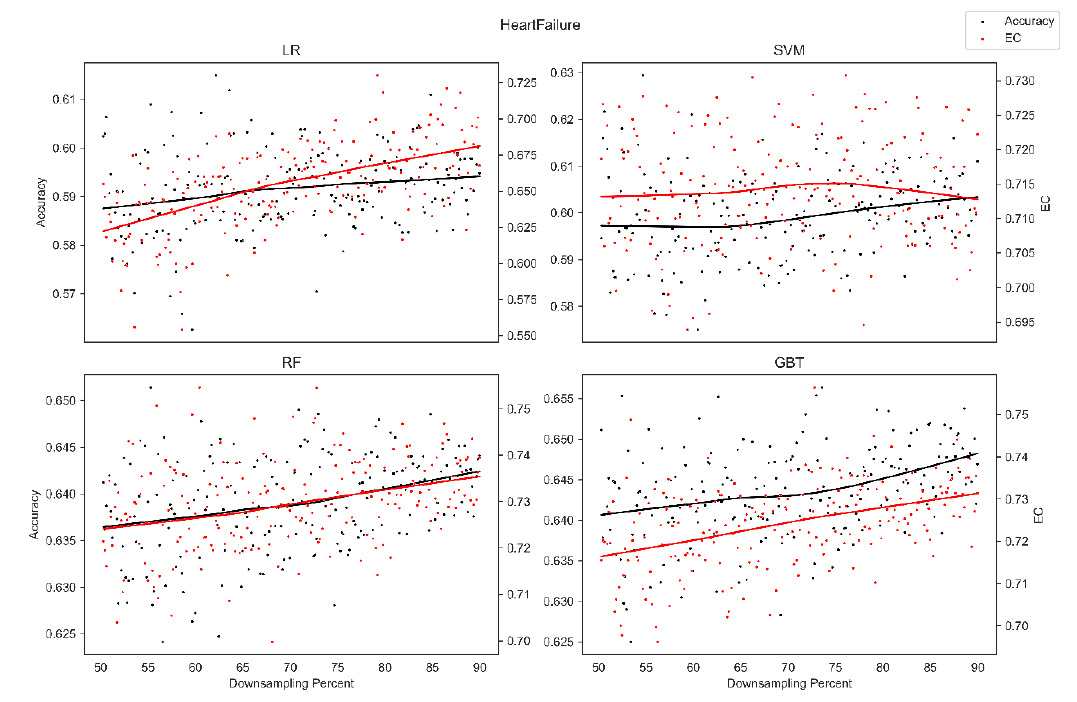
Figure 5. Average error consistency and overall accuracy vs. varying sample size percentages (down-sampled) from the Heart Failure dataset. Trend lines were established with locally weighted regression and smoothing [25].